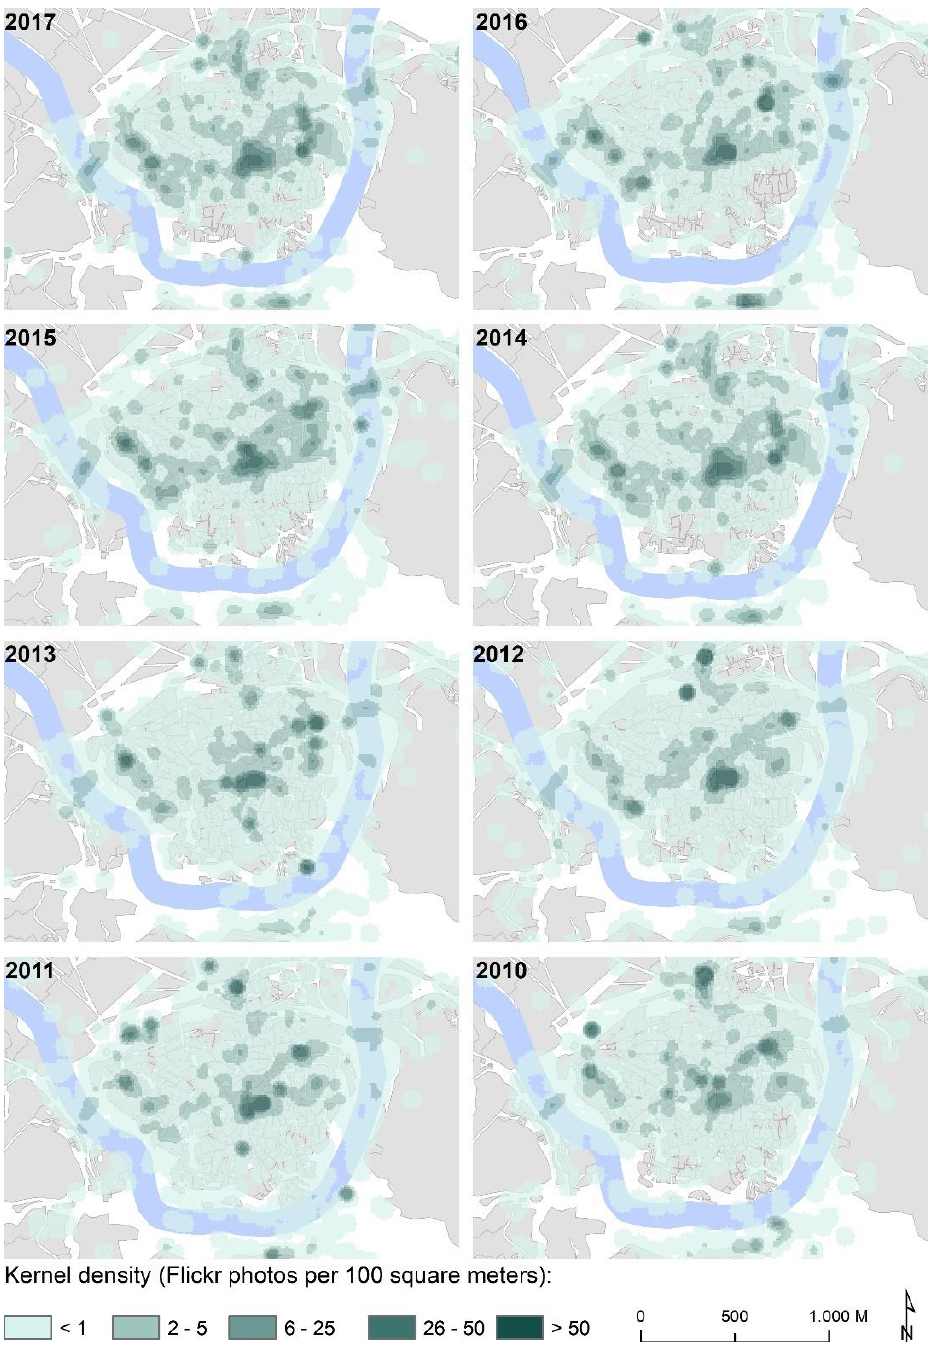
Figure A2. Density of Flickr photos in the historic centre of Toledo. Note: the weight of each photo was normalised considering the maximum number of photos per year. Source: Authors’ own elaboration.